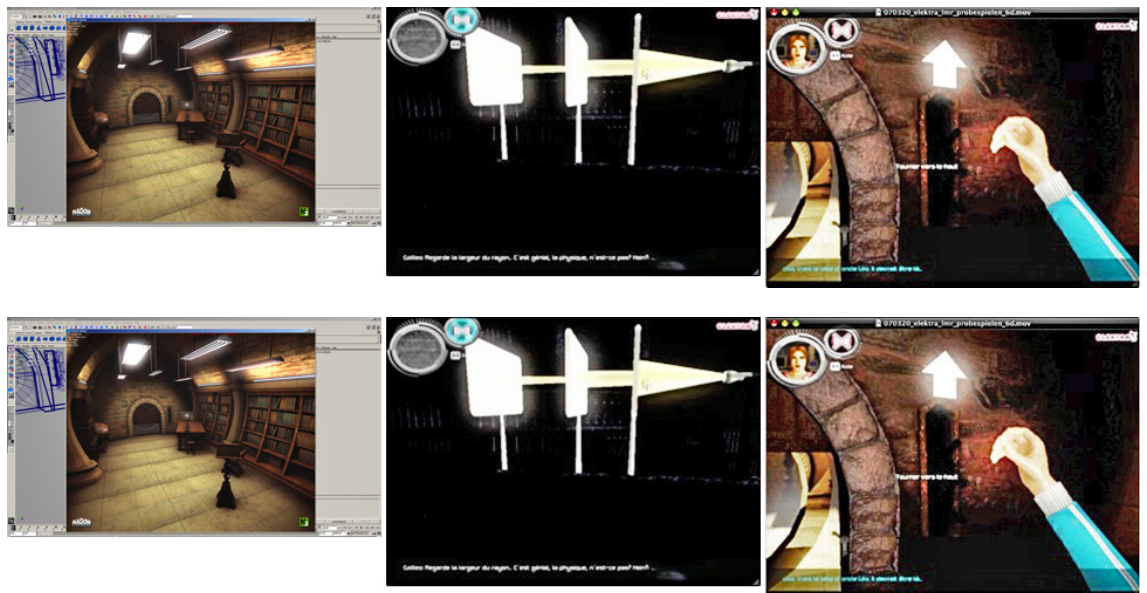
Figure 1. Conventional design of Elektra without support. The second design condition (G_ES) is similar to the first in that no support is given. Rath - er, descriptions of the relevant learning concepts are presented in a separate hyperlinked textbook. The learners are made aware of the support device that is always available by a permanently visible button with a hyperlink to the textbook (see Figure